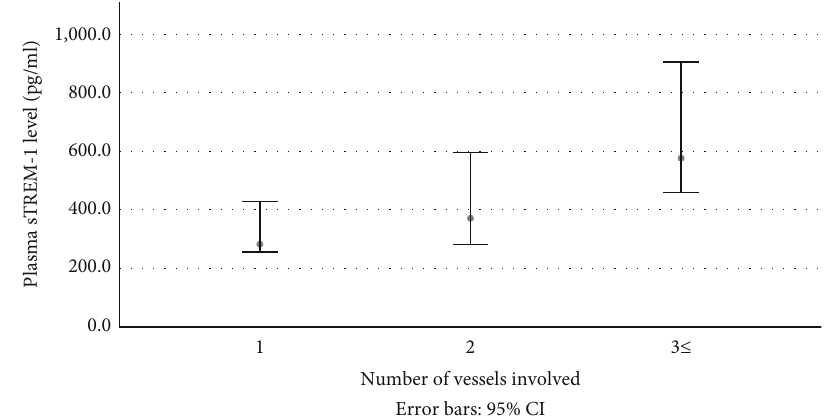
Figure 3: Median (i/q range) of plasma sTREM-1 level (pg/ml) in ACS patients strati fi ed by number of stenosed/occluded coronary arteries as diagnosed on cardiac catheterization ( P < 0 : 001